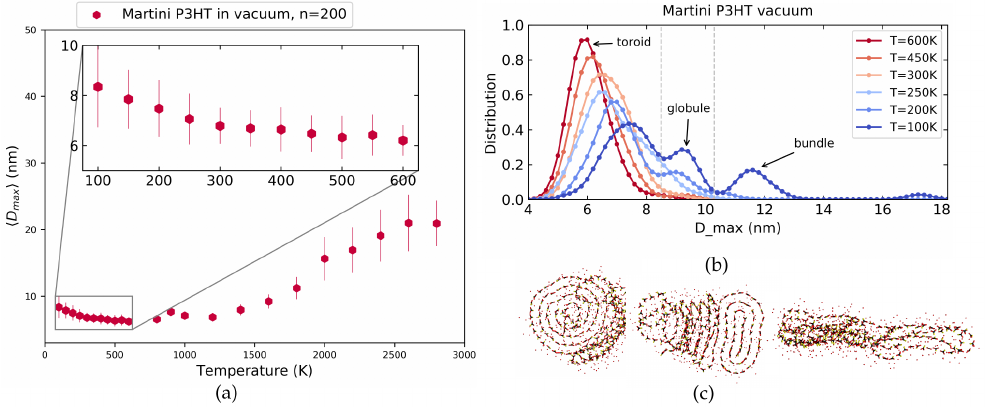
Figure 7. The maximum distance between monomers for the Martini model of P3HT in vacuum. ( a ) Averaged D max as a function of temperature. ( b ) Distributions at various temperatures. ( c ) Illus- tration of the corresponding conformations: toroids, tight globules and